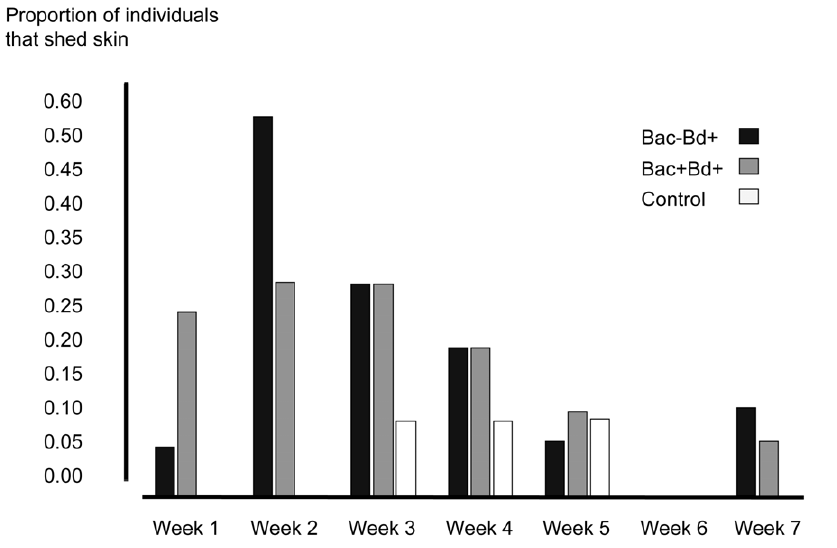
Figure 3. Proportion of individuals in treatments Bac + Bd + ( n =21), Bac 2 Bd + ( n =21), and control ( n =13) that lifted their limbs off substrate for at least five minutes each week.